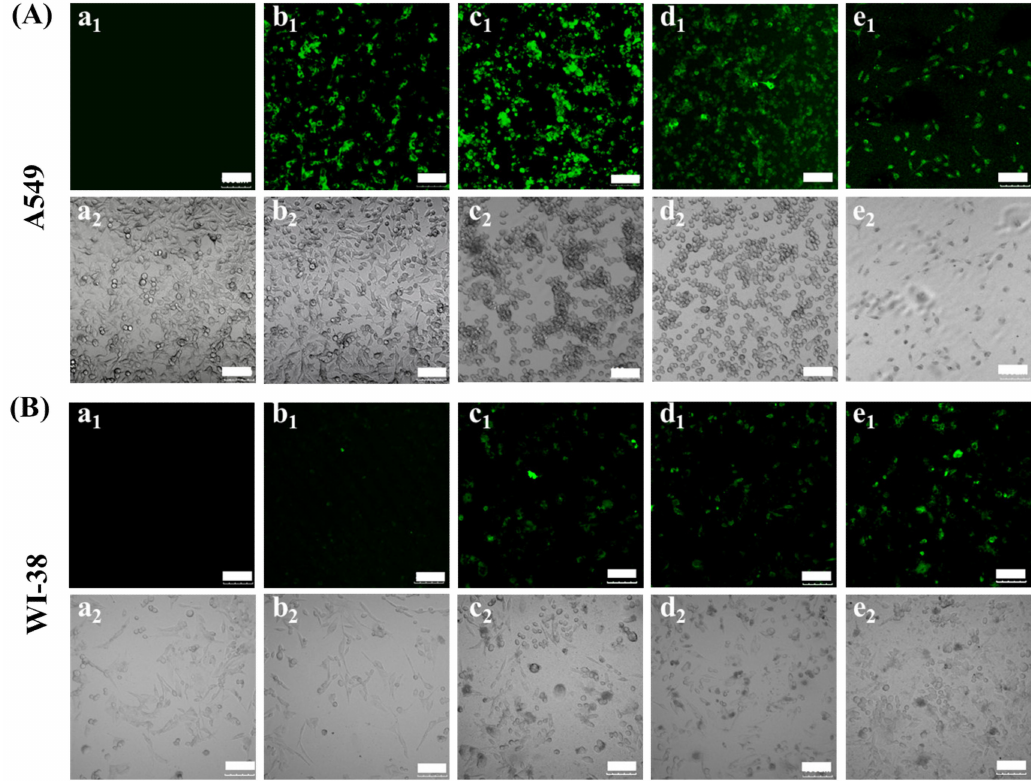
Figure 5. ( A ) Fluorescent micrographs of A549 cells transfected with different formulations. ( B ) Fluorescent micrographs of WI-38 cells transfected with different formulations. ( a ): Untreated cells; ( b – d ) represent CBSF/pDNA complexes with ratios of 64/2, 128/2, and 256/2, respectively; ( e ): A 25 kDa PEI/pDNA complex at a w / w ratio of 10/2. ( a 1 – e 1 ) and ( a 2 – e 2 ) denote the fluorescent field and bright field, respectively. Scale bar: 50 µ